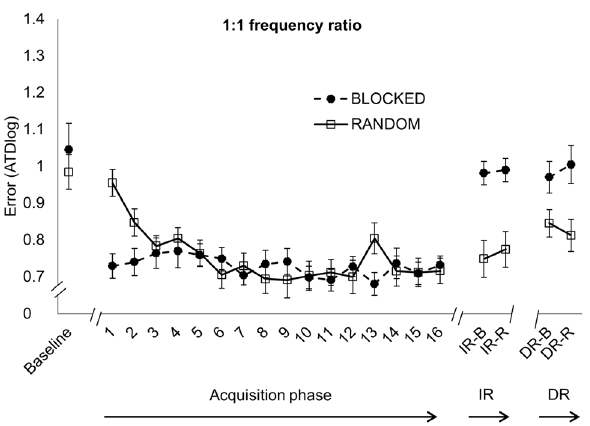
Figure 5. 2:3 frequency ratio. Error score (ATDlog, i.e. the log- transformed average target deviation) for baseline, acquisition phase (TR1-16), immediate retention (IR) and delayed retention (DR) (mean 6 standard error) learned under either a blocked (black circles) or randomized (white squares) practice schedule. Better performance is indicated with lower levels of ATDlog.